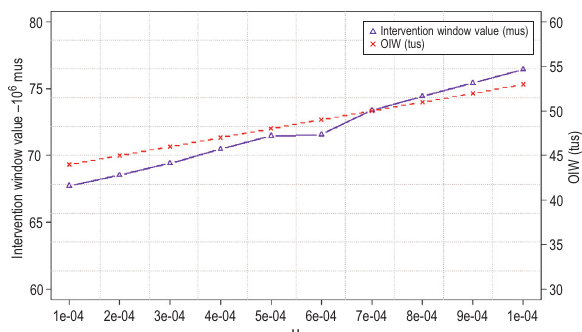
Fig. 3. Values of optimal intervention windows for different values of the discount factor